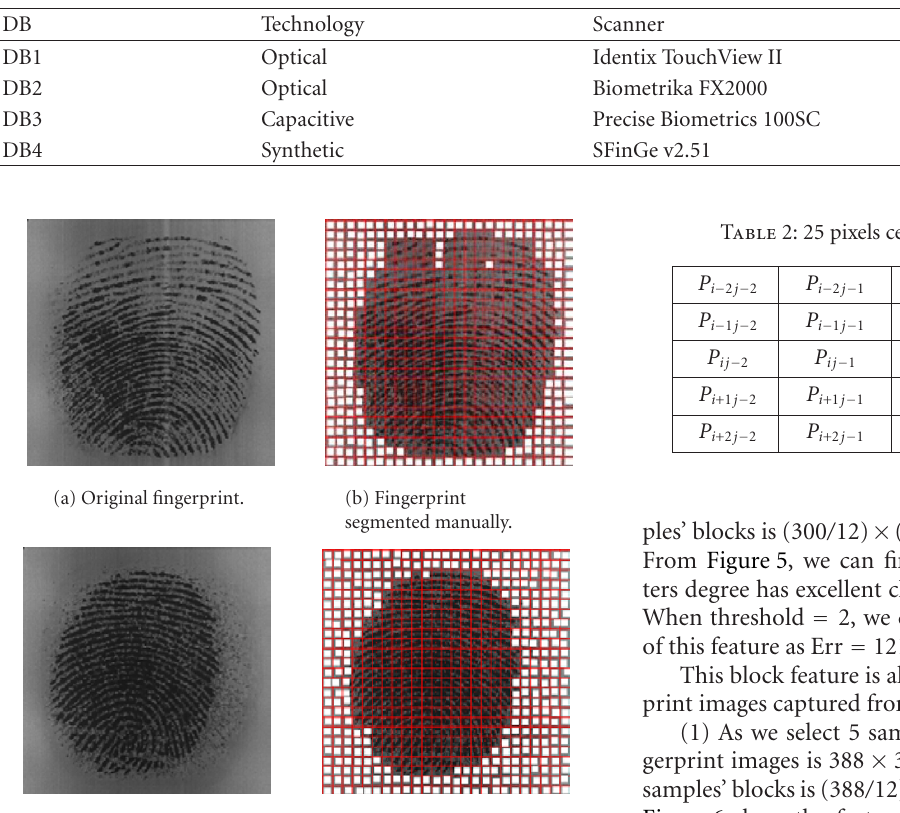
Table 1: Scanners/technologies used for the collection of FVC2002 databases.